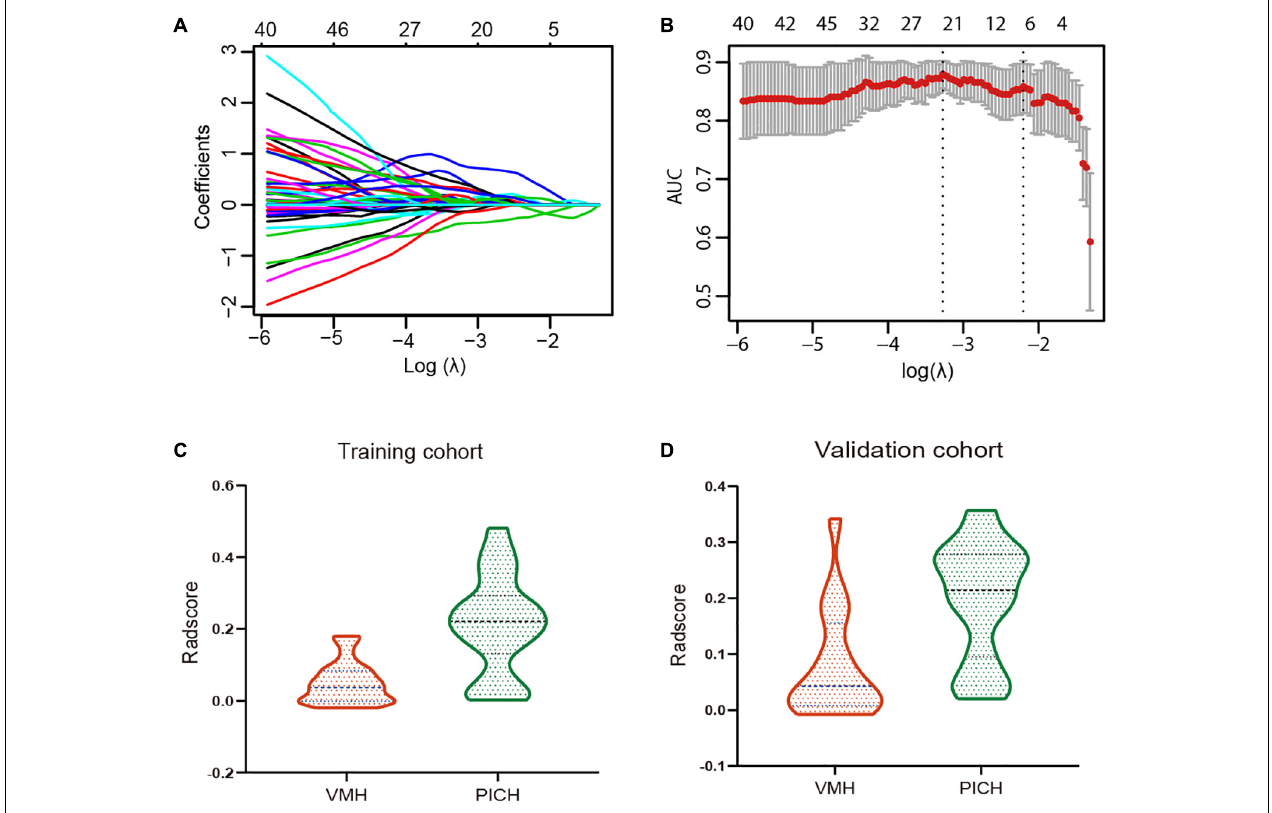
FIGURE 2 | (A) Tuning parameter ( λ ) selection in the least absolute shrinkage and selection operator (LASSO) regression used fivefold cross-validation via one standard error (SE) of the minimum criteria. The optimal λ value was 0.1212 with log( λ ) = 2.1095. (B) LASSO regression coefficient of the 532 radiomics features generated vs. the selected log( λ ) value. (C,D) The violin plots for radiomics signature in the training and validation cohorts, categorized by the vascular malformations-related hemorrhage (VMH) and PICH groups.